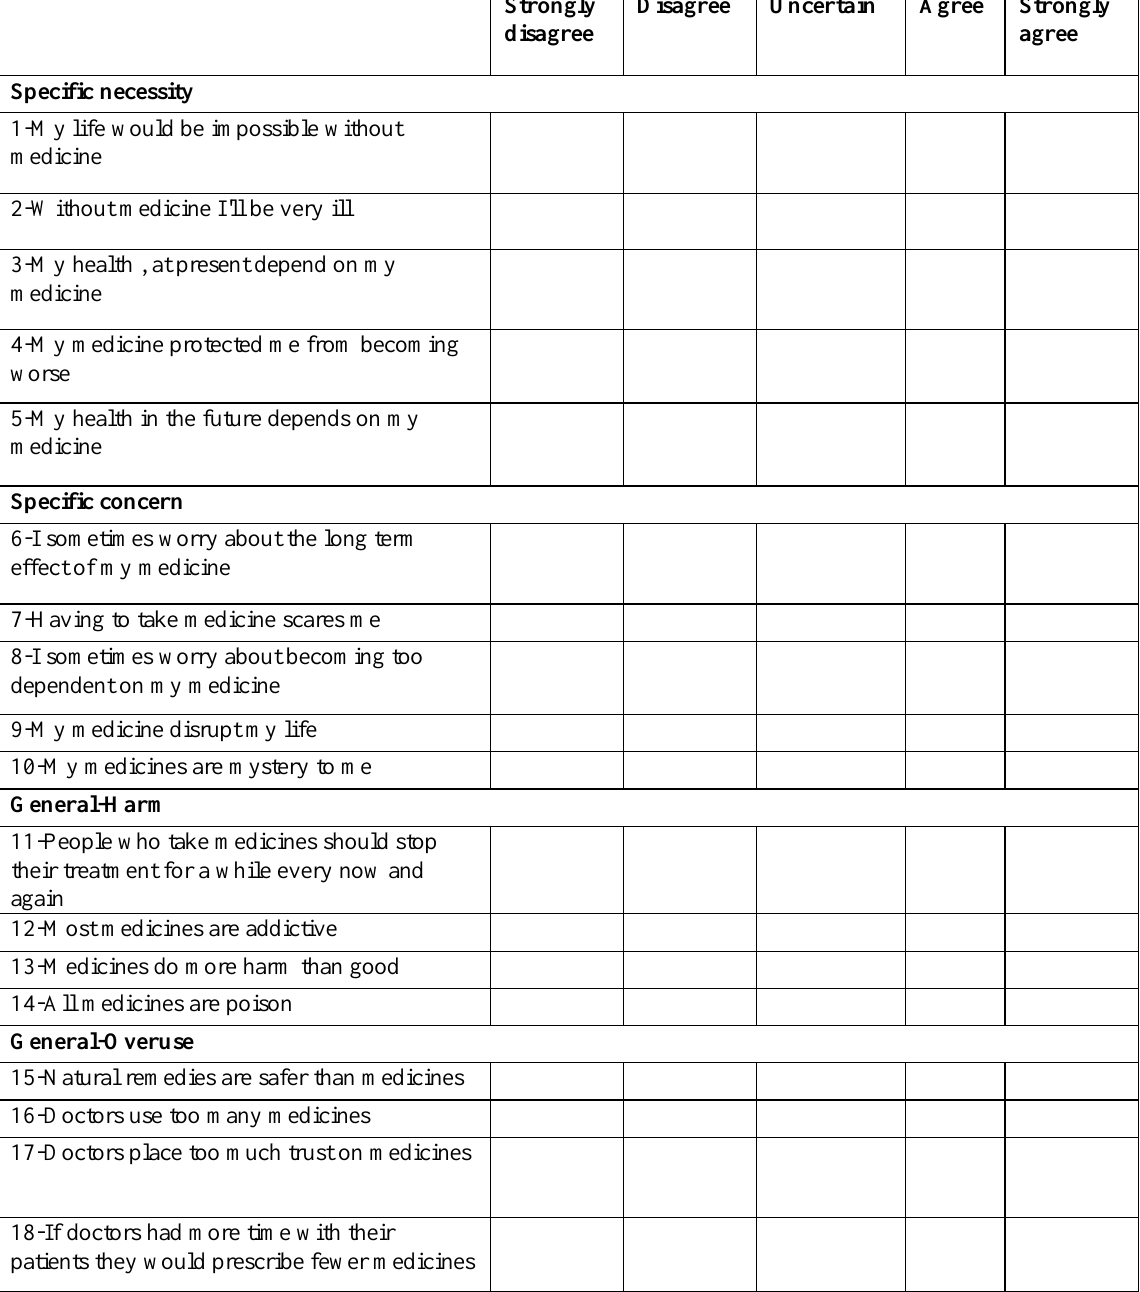
Figure 1. The beliefs about medicines questionnaire (BMQ) (15)